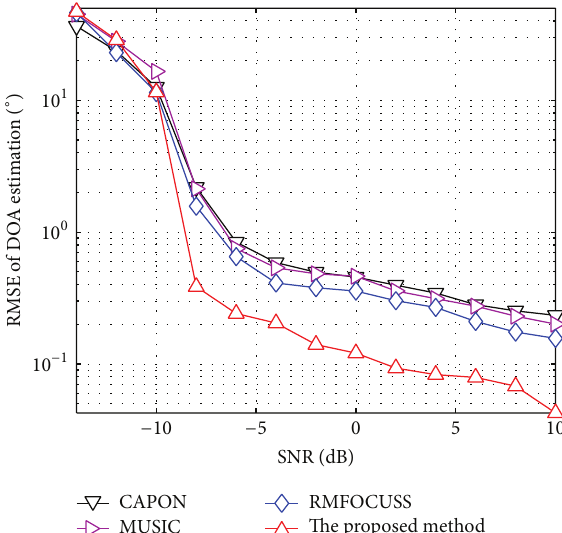
Figure 2: RMSE of the DOA estimates versus input SNR.